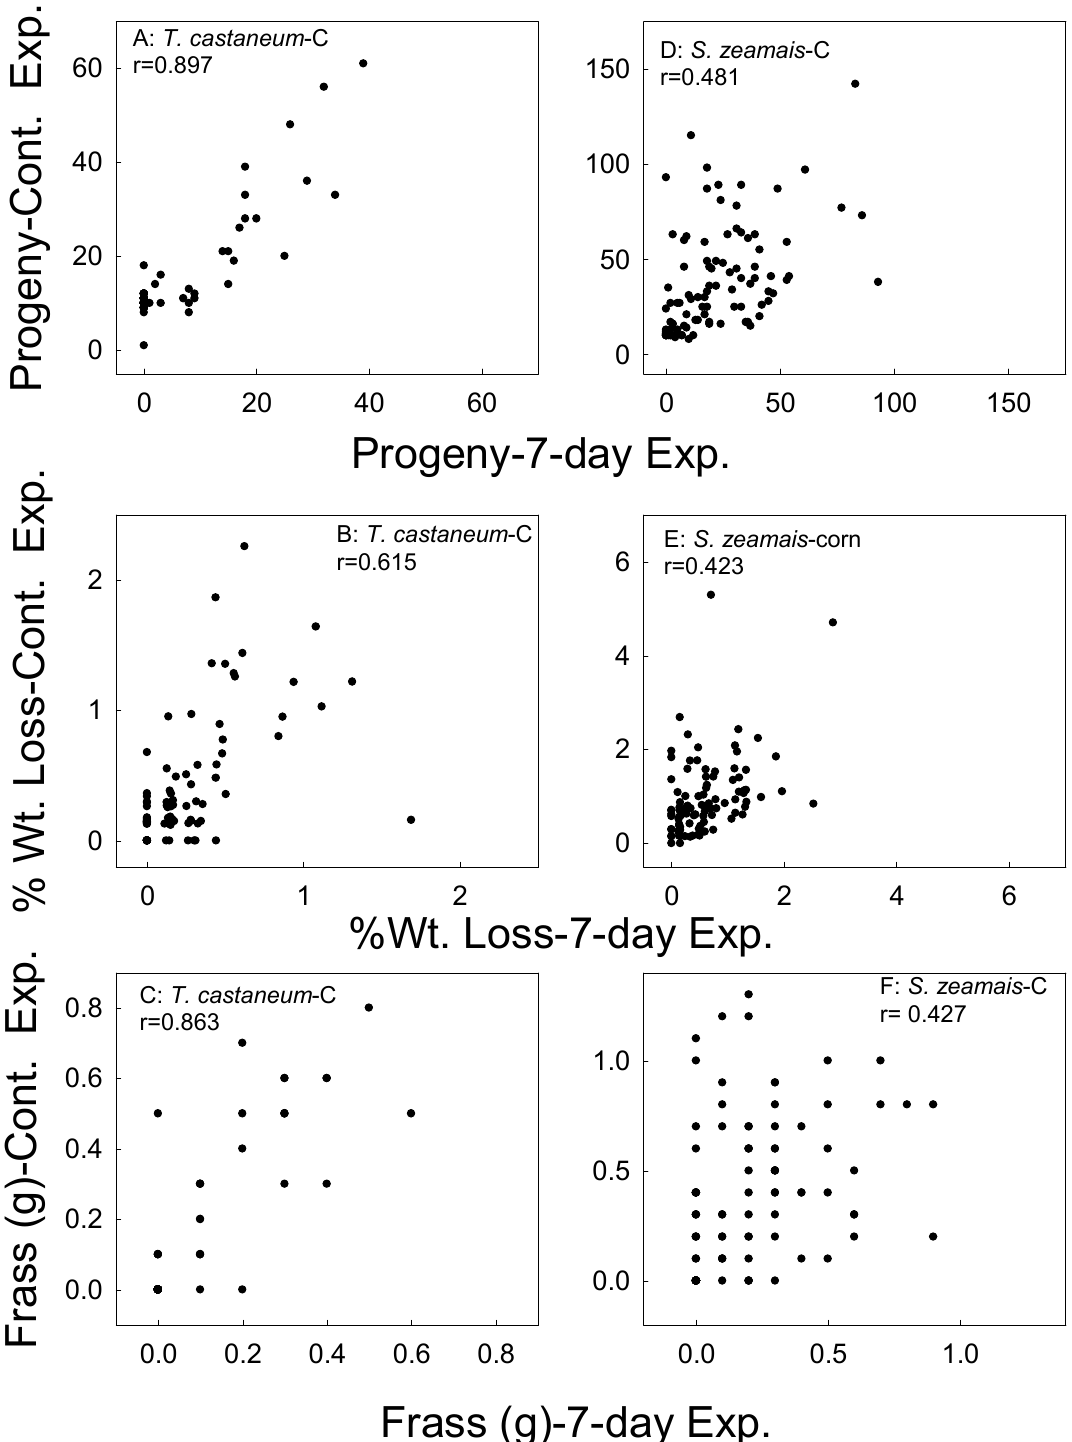
Figure 5. Correlation of F 1 progeny, sample weight loss, and frass weight in the corn ( C ) samples whereby parental adults were exposed for 7 days versus the continual exposures of parental adults for T. castaneum ( A – C ) and S. zeamais ( D – F ). Data combined for all treatments and all bioassay months.